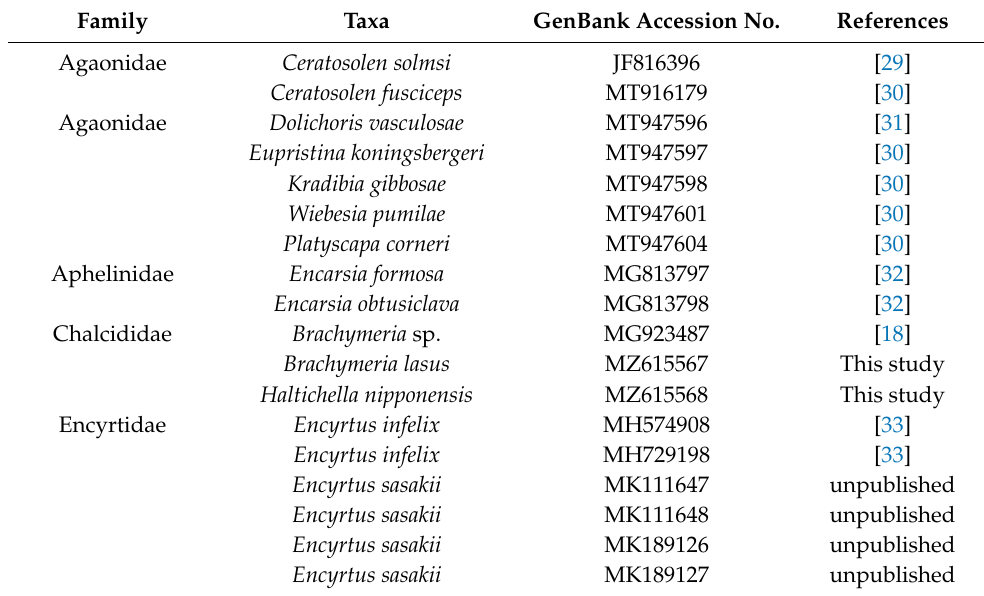
Table 1. Mitogenomes of Chalcidoidea and outgroups used in this study. Family Taxa GenBank Accession